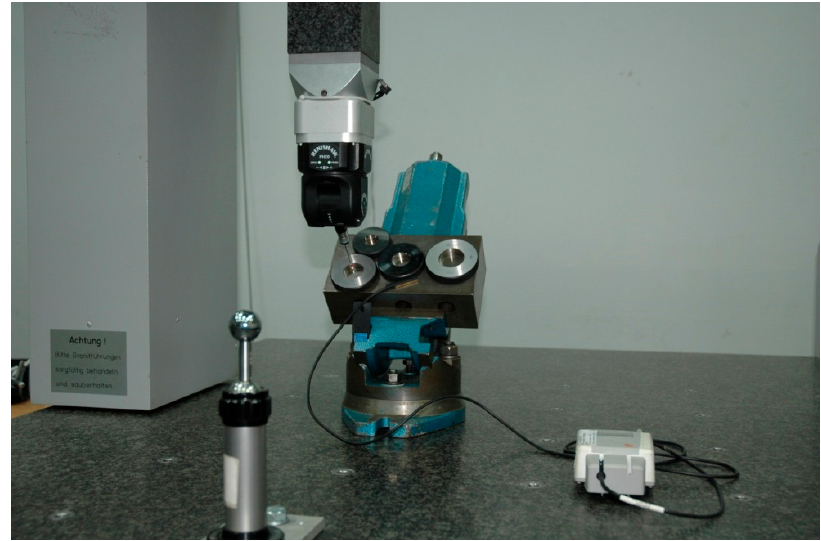
Figure 1. Five-axis measuring system and standards used during the experiments.